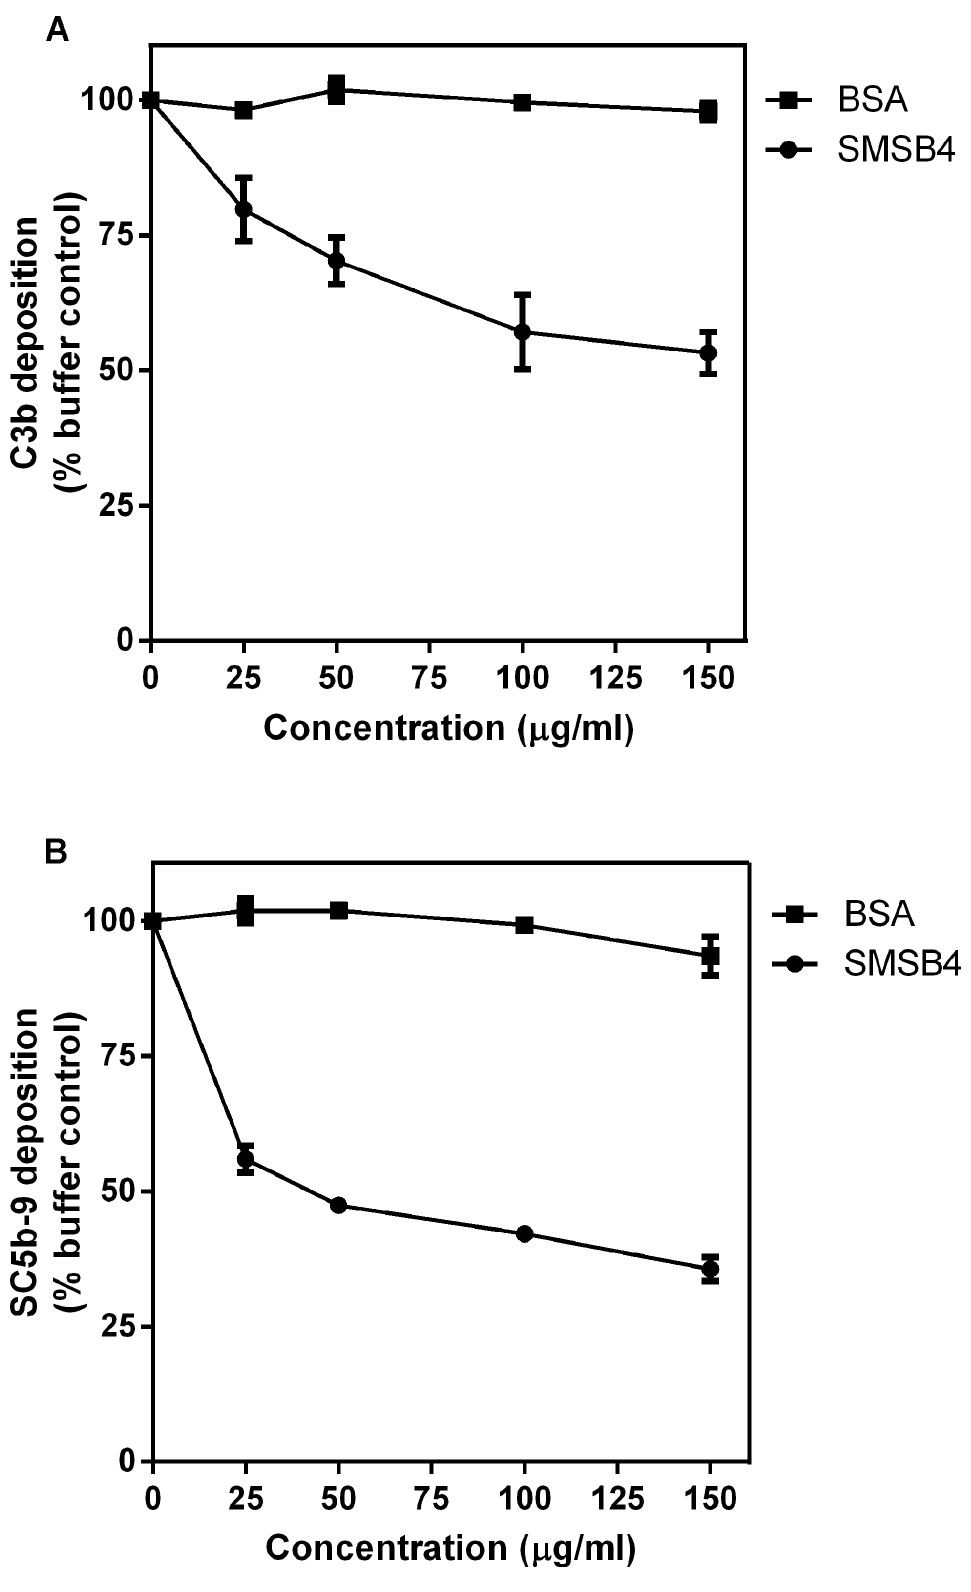
Figure 3. SMSB4 reduces deposition of C3b ( A ) and MAC complex (SC5b-9) formation ( B ). Thewells of 96-well microtiter plates were coated with 100 m l aliquots of bacterial cell suspensions containing 5 6 10 6 cfu/ml of S. aureus . Wells were then incubated with 10% NHS which has been pre- treated with increasing concentrations of either SMSB4 or BSA. Antibodies were detected by ELISA using primary human specific antibodies, followed by HRP-conjugatedsecondaryantibodies,andfluorescencewasdetectedat490 nm.Resultsare shownas means 6 SEMfromthreeindependentexperiments.